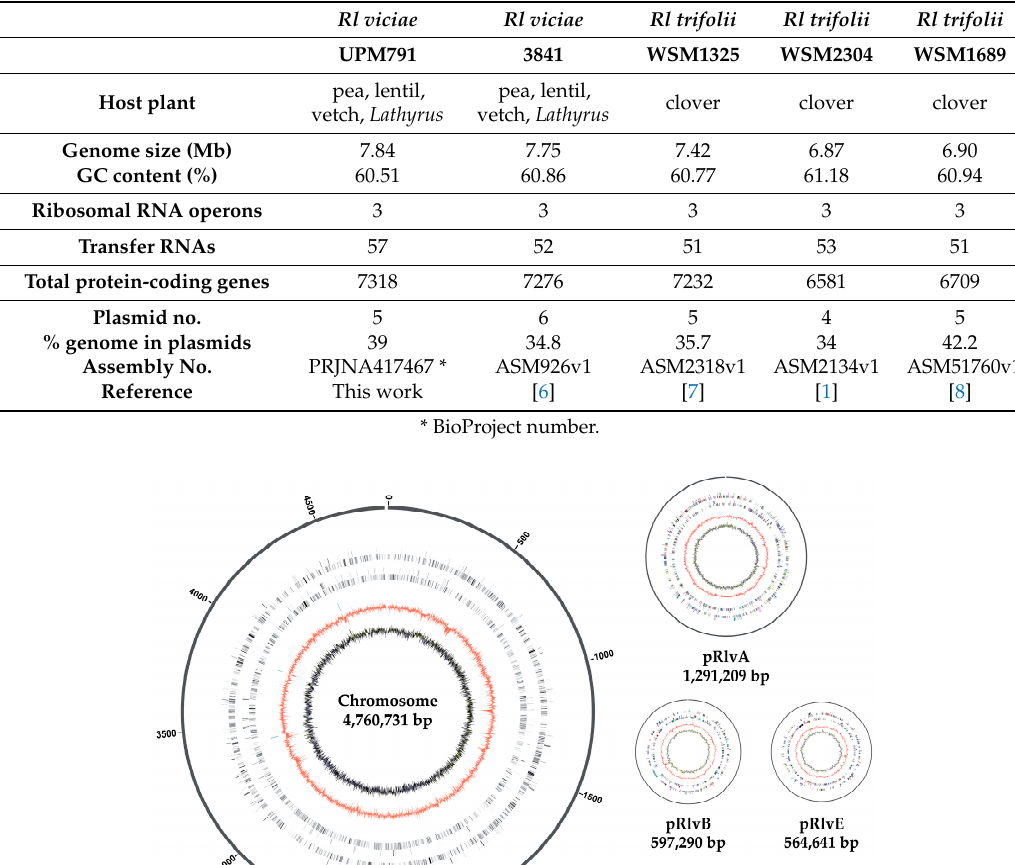
Table 1. General features of Rhizobium leguminosarum ( Rl ) complete genome sequences (data from IMG/M database).